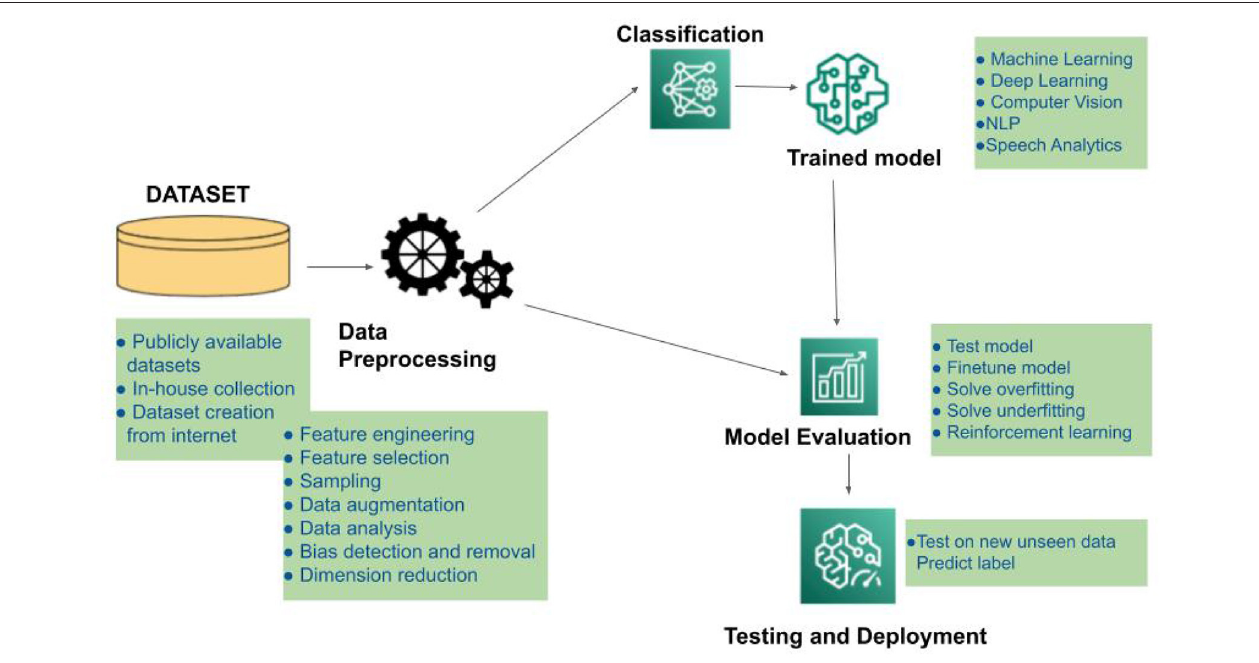
FIGURE 1 | Illustrating different states of an AI based